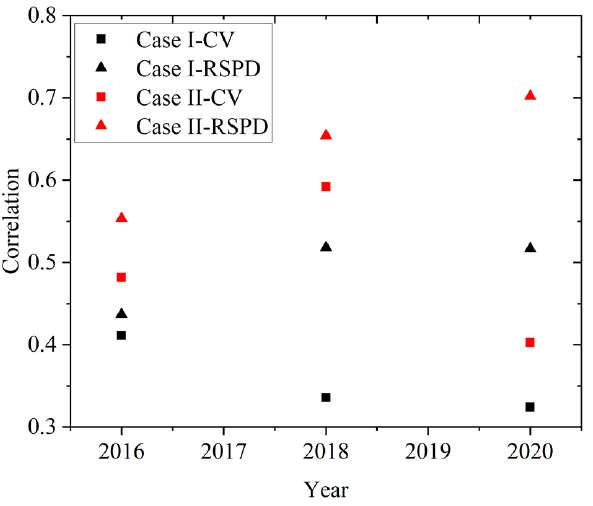
Figure 12. Correlation efficient between RSPD/CV and sample data from Google Earth images.